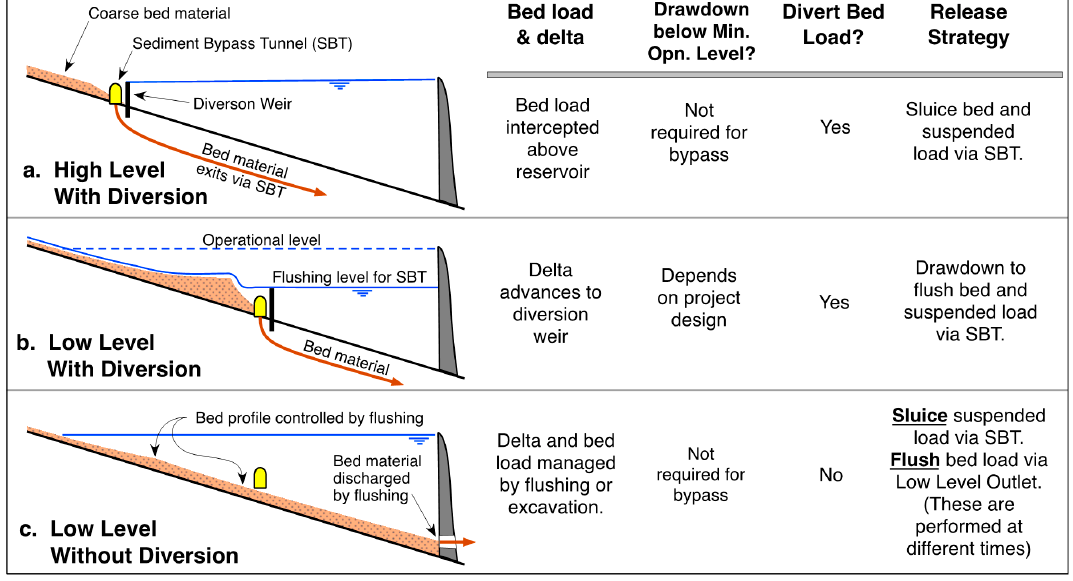
Figure 4. Sediment bypass configurations showing distinctive characteristics of each.